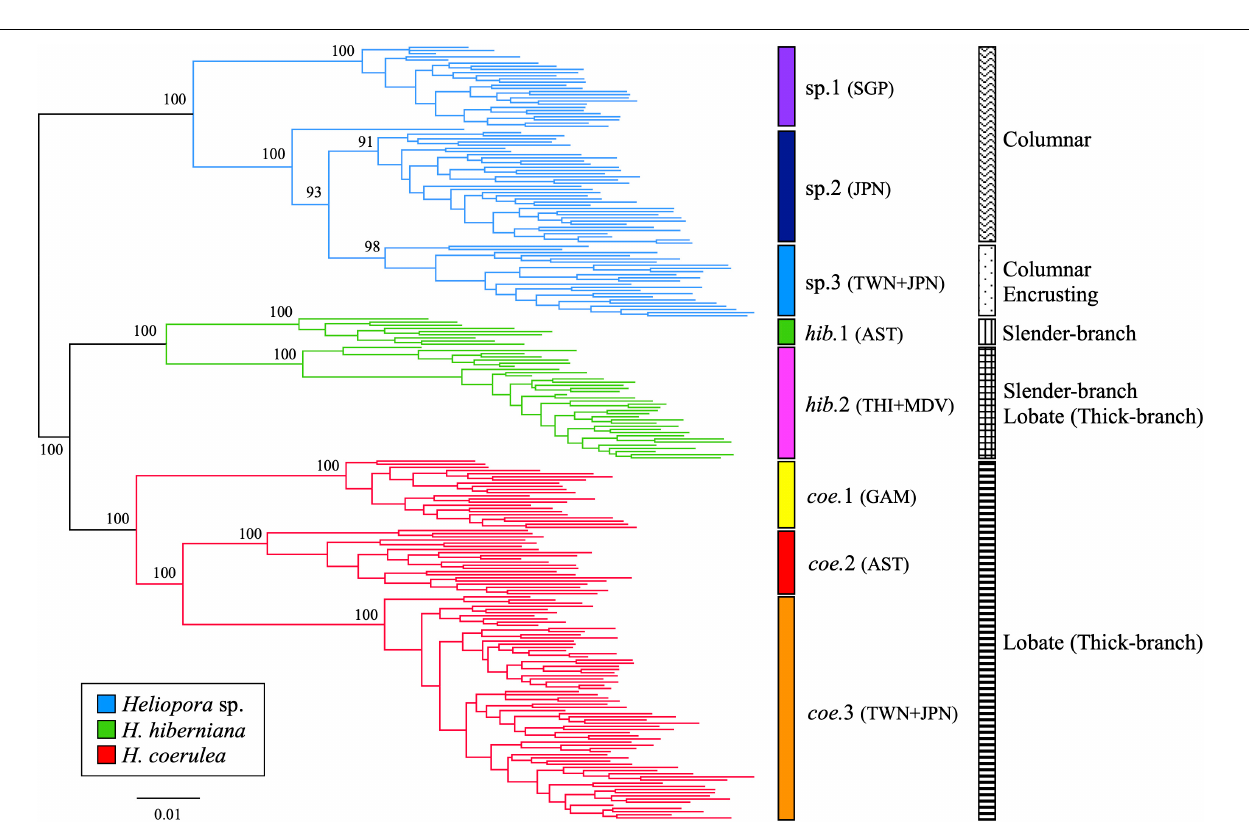
Frontiers in Marine Science |